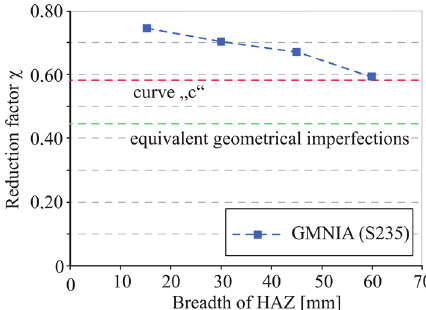
Fig. 18. comparison of numerical results with buckling curves for steel s235